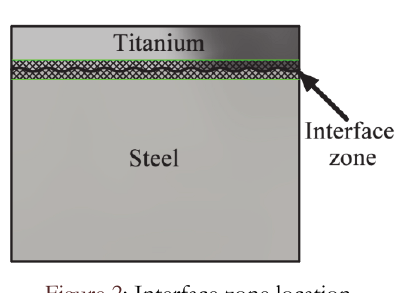
Figure 2: Interface zone location